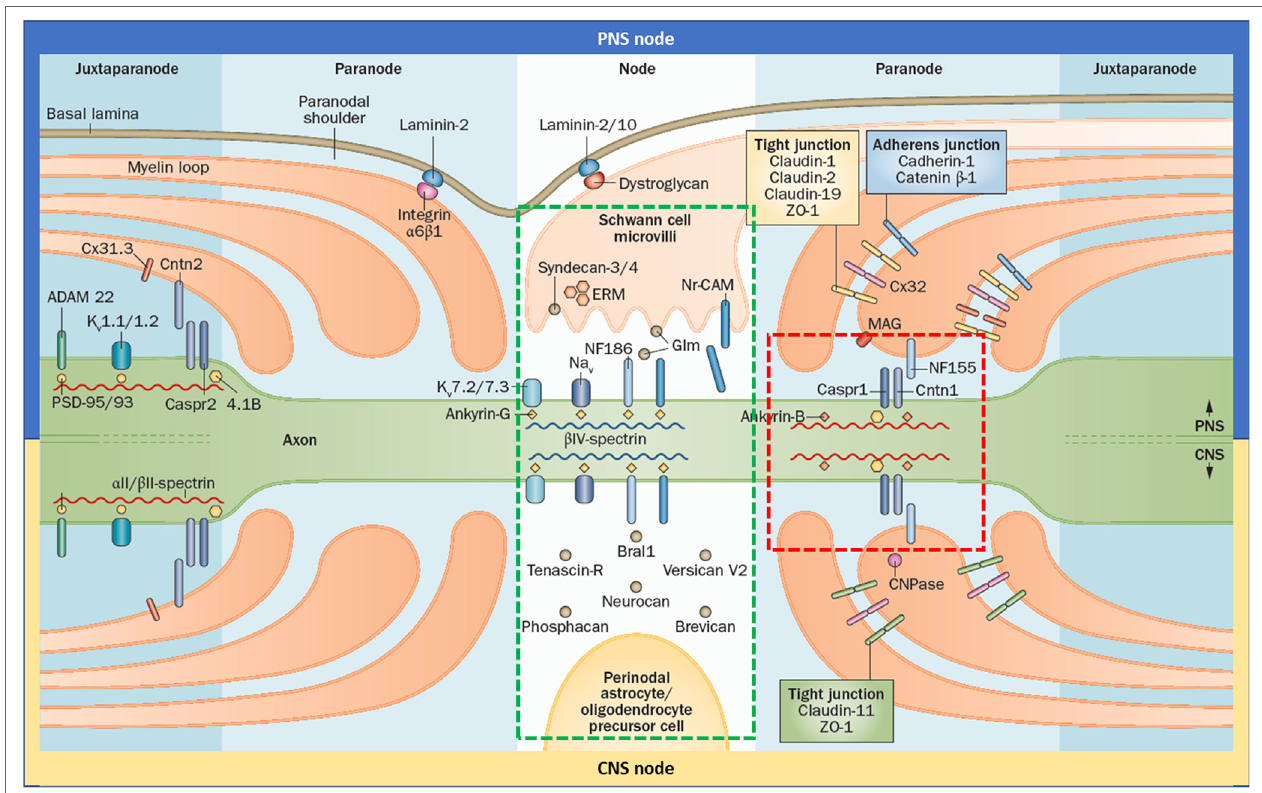
FiGURe 1 | Gross and molecular structure of the node of Ranvier in central nervous system (CNS) and peripheral nervous system (PNS). Cell adhesion molecules forms complex with other adhesion molecules, ion channels, and the cytoskeleton to form the nodal, paranodal, and juxtapranodal compartments. The main difference between the CNS and PNS nodes is the interaction partners of neurofascin 186 (NF186). The targets of the autoantibodies found in patients with seropositive chronic inflammatory demyelinating polyneuropathy are neurofascin 155, Cntn1, and contactin-associated protein 1, which altogether form a complex in the paranode (red rectangle); and NF186 that is located in the node (green rectangle) and also in the axon initial segment. Reprinted by permission from Springer Customer Service Centre GmbH: Springer Nature [COPYRIGHT]